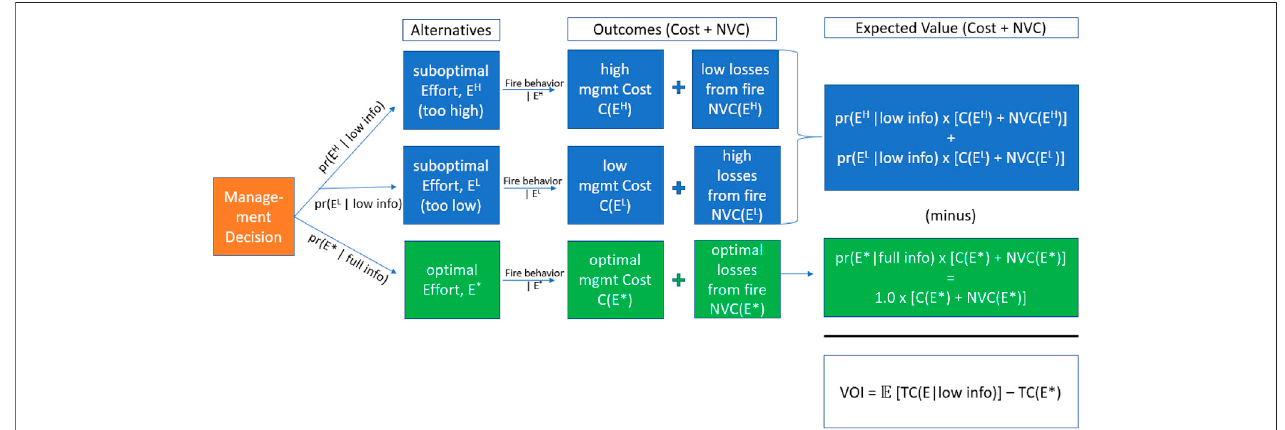
FIGURE 3 | VOI for a simpli fi ed 1-input problem: optimal